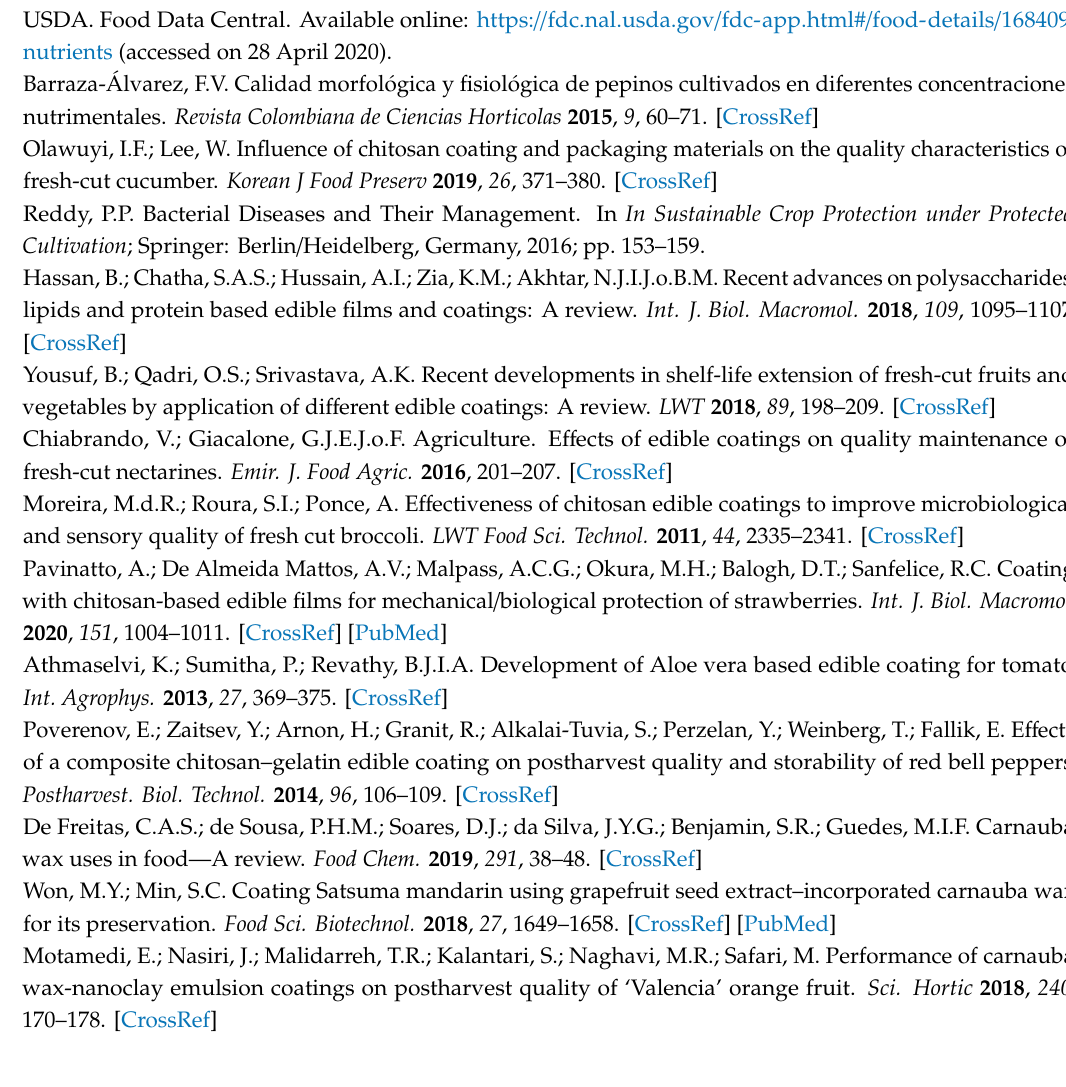
Figure S1: Global e ff ect of chitosan, wax, chitosan-wax, chitosan-OEO, wax-OEO, and chitosan-OEO-wax coatings on the firmness of the cucumbers stored at 10 ◦ C for 15 days. Values are means of n = 3. Di ff erent literals among treatments indicate significant di ff erences ( p ≤ 0.05), Figure S2: Global e ff ect of chitosan, wax, chitosan-wax, chitosan-OEO, wax-OEO, and chitosan-OEO-wax coatings on the surface color of the cucumbers stored at 10 ◦ C for 15 days. Values are means of n = 3. Di ff erent literals among treatments in the same parameter indicate significant di ff erences ( p ≤